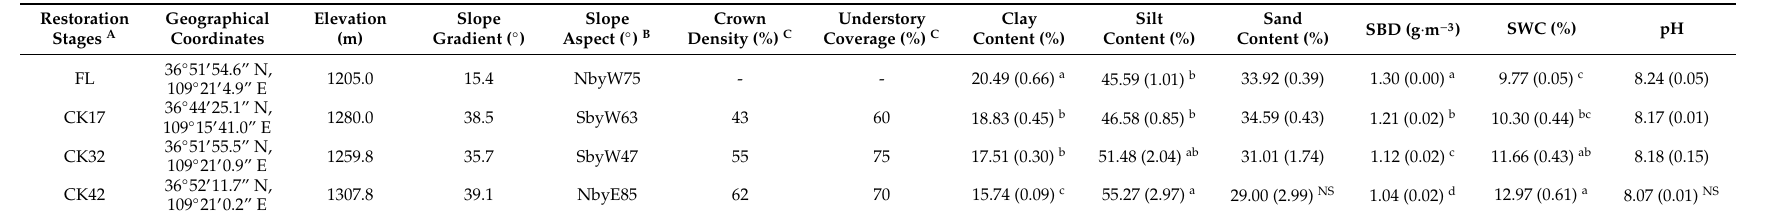
Table 1. Geographical features and soil physical properties at di ff erent stages of vegetation